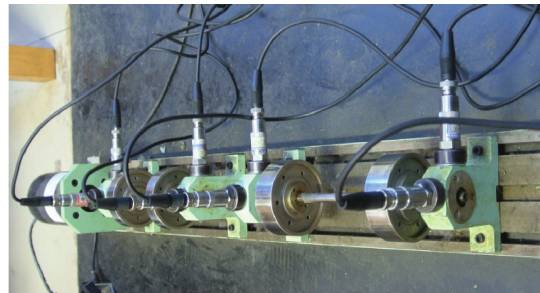
Figure 5: The arrangement of measuring points of vibration